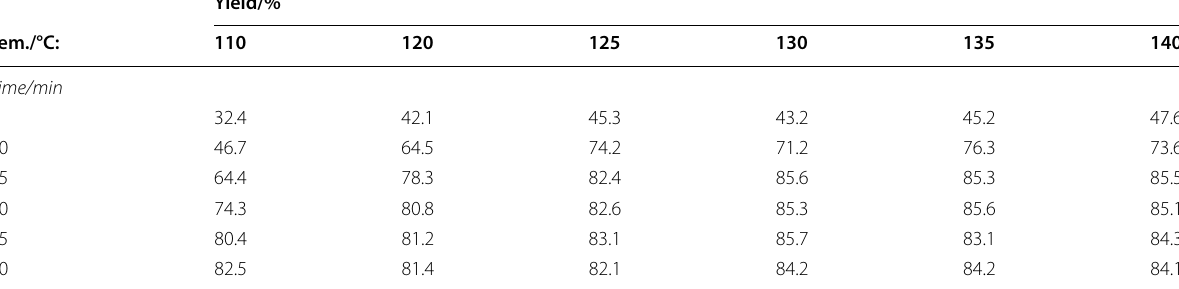
Table 2 Optimization of amination reaction